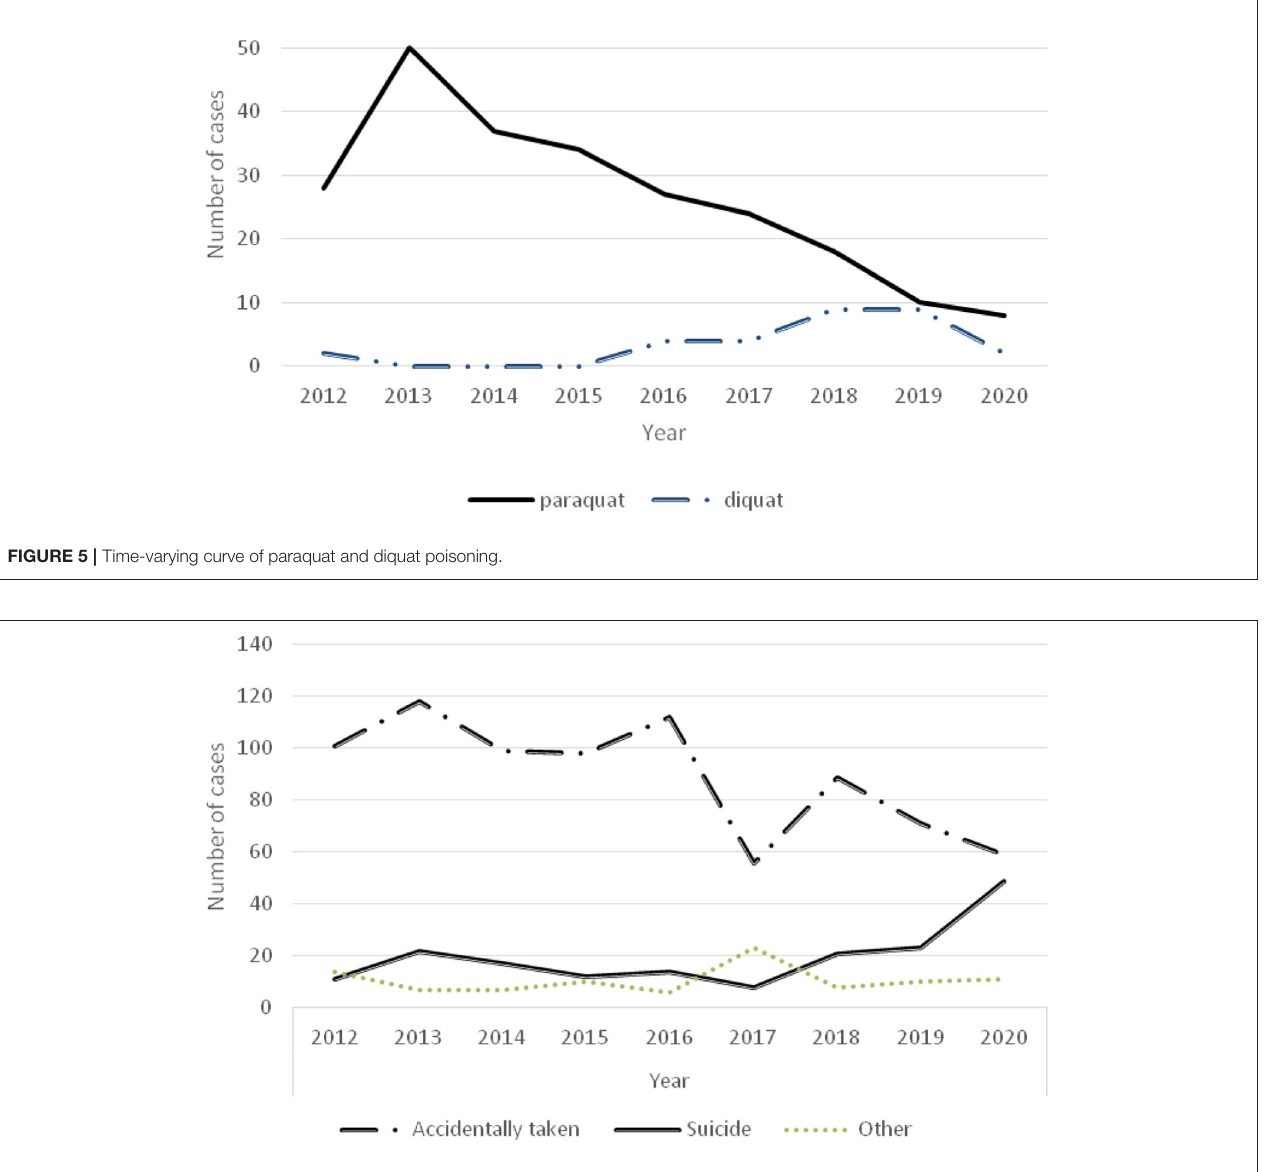
FIGURE 6 | Time-varying curve of cause of